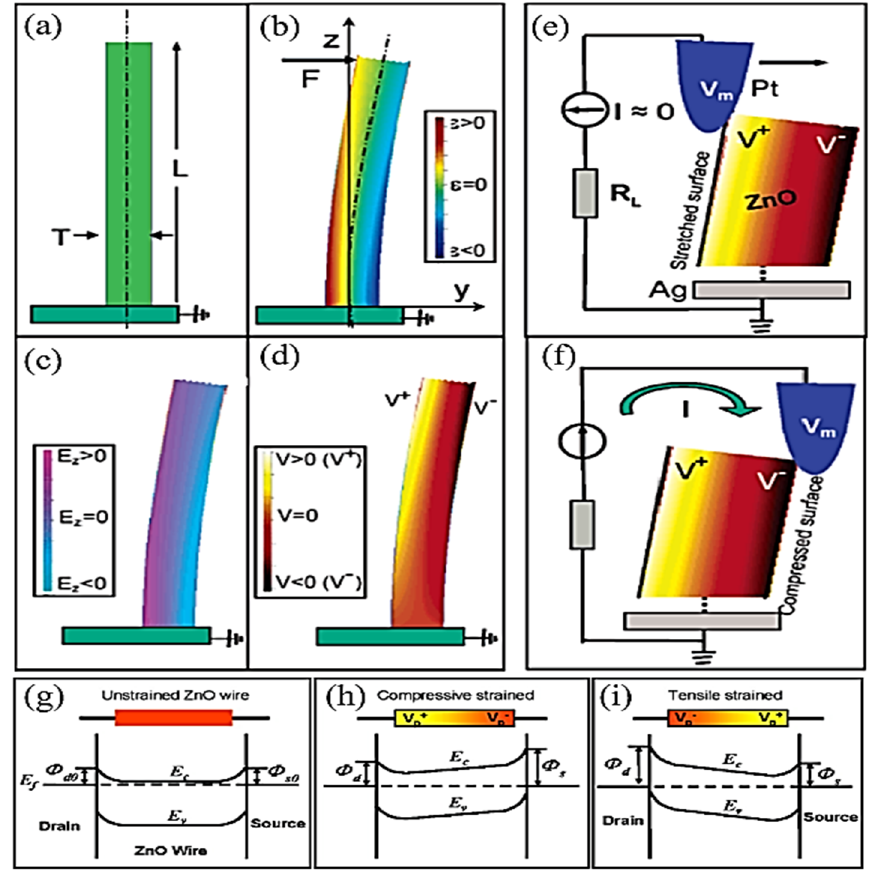
Figure 15. ( a–d ) A unique coupling of piezoelectric and semiconducting properties for the power- generating processes of a ZnO nanowire with thickness and length. ( e , f ) Schematic contact field between the conductive AFM tip and single ZnO, showing reverse- and forward-biased Schottky rectifying behavior. Figure ( g–i ) The fields developing within horizontal ZnO NWs and near the Schottky contacts for unstrained, compressed, and stretched NWs Reprinted with permission from ref. [143]. Copyright 2006 American Chemical Society. Reprinted with permission from ref. [160]. Copyright 2018 Elsevier.